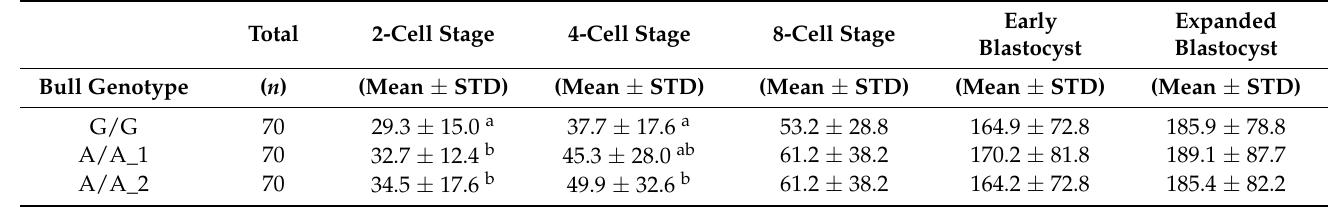
Table 3. Effect of sire genotype on hours (h) after fertilization to reach distinct morphological embryonic stages.